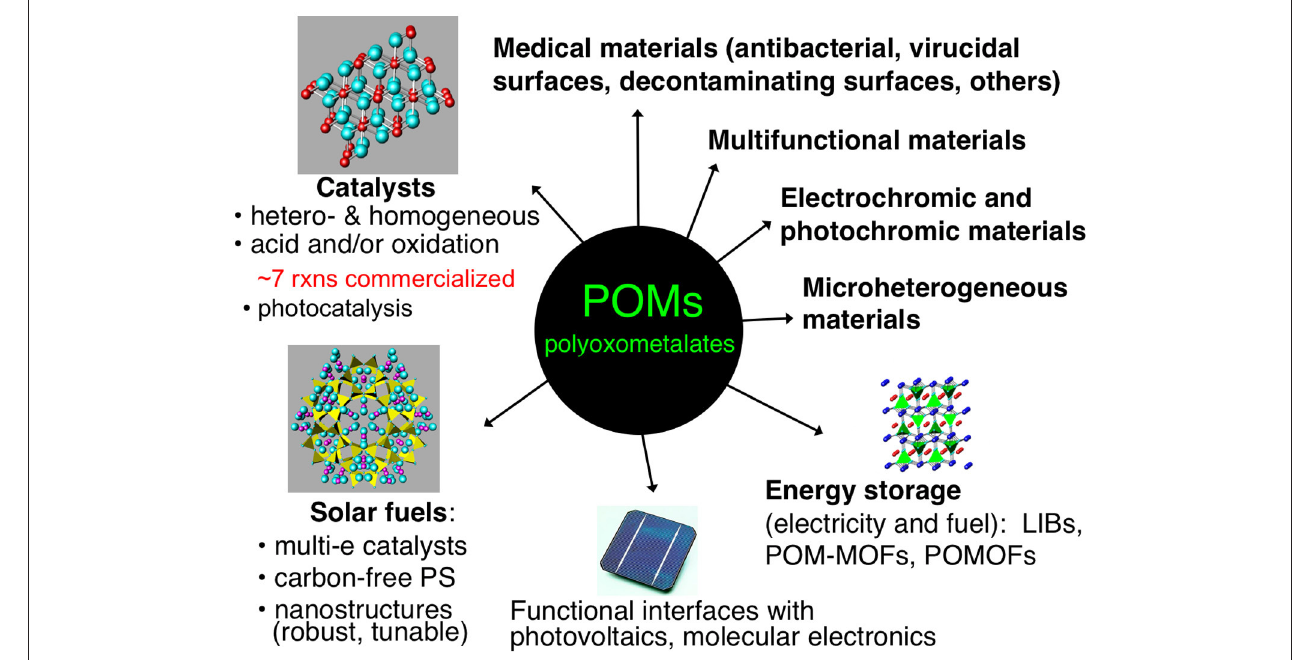
FIGURE 1 | Some uses and ongoing research efforts involving POMs in materials.